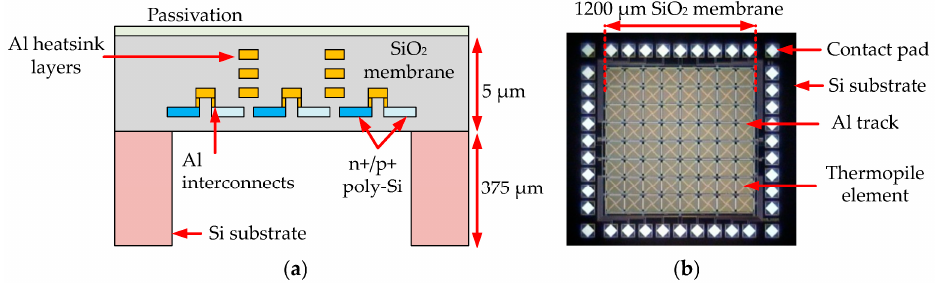
Figure 1. ( a ) Cross-sectional view showing the p + / n + poly-Si and Al layers of the thermopile array; ( b ) Optical image of the thermopile array. Chip size = 1.76 mm × 1.76 mm.